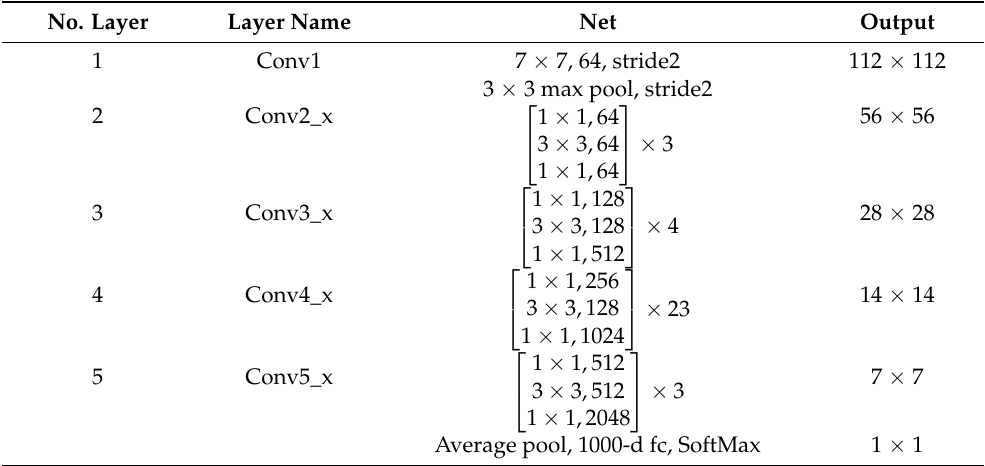
Table 1. Structure and output size of the different layers of ResNet101. No. Layer Layer Name